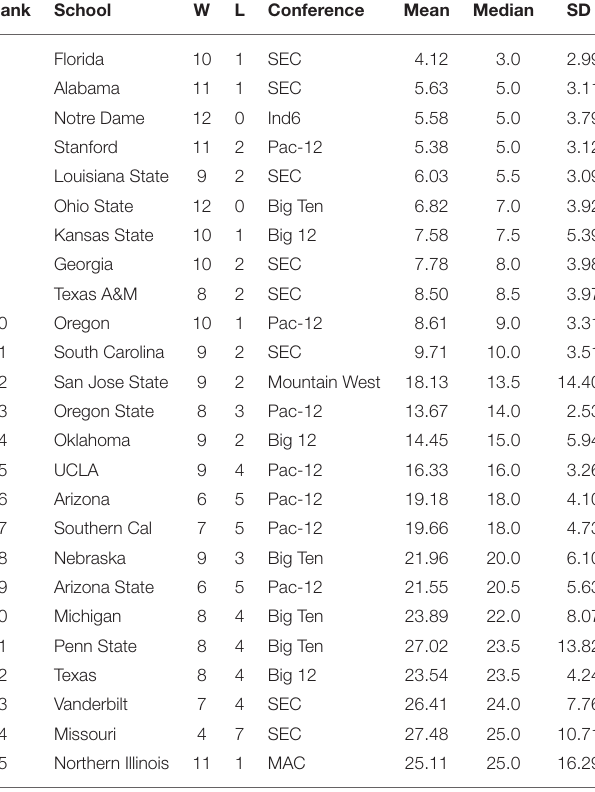
TABLE 1 | Top 25 NCAA football teams for the 2012 season as ranked with respect to microstate ensemble. Rank School